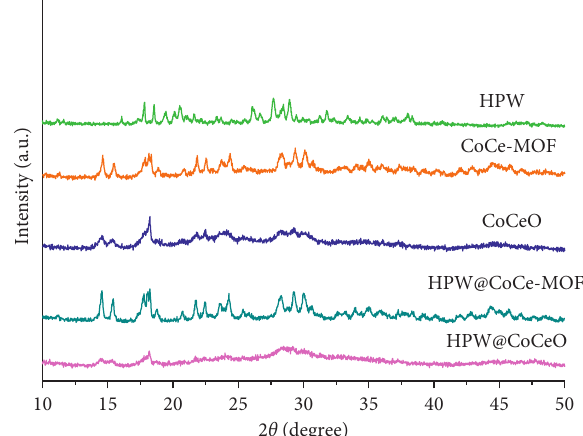
Figure 1: XRD spectra of HPW, CoCe-MOF, CoCeO, HPW@CoCe-MOF, and HPW@CoCeO composites.